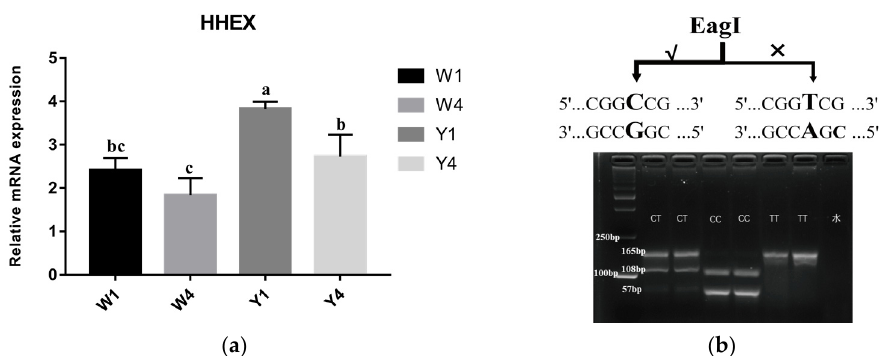
Figure 3. ( a ) HHEX mRNA expression levels in the thoracic vertebral cartilage tissues of Y1, Y4, W1, and W4. Values shown are the mean ± SE. Different letters indicate significant differences ( p < 0.05); the same letters indicate no significant difference. Y1, 1 ‐ month ‐ old Yorkshire pigs ( n = 3); Y4, 4 ‐ month ‐ old Yorkshire pigs ( n = 3); W1, 1 ‐ month ‐ old Wuzhishan pigs ( n = 3); W4, 4 ‐ month ‐ old